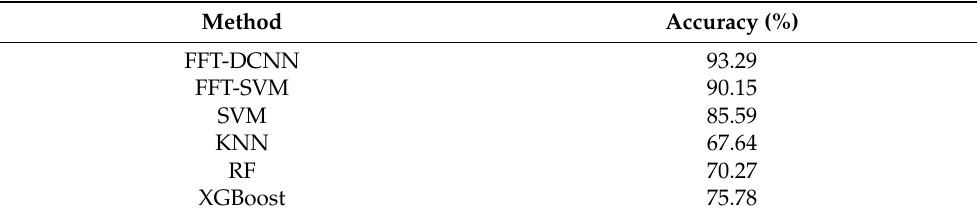
Table 5. Comparison result between the proposed method and ML